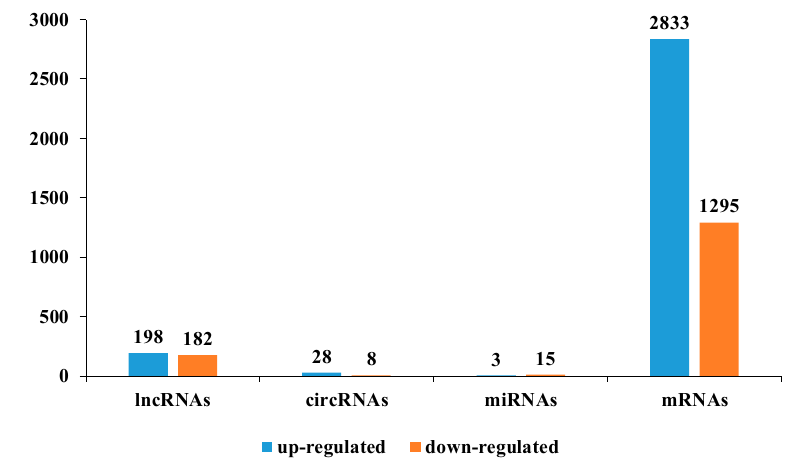
Figure 2. Differentially expressed (DE) ncRNAs: 380 lncRNAs, 36 circRNAs, 18 miRNAs, and 4128 mRNAs were found differentially expressed between the control and chilling groups.